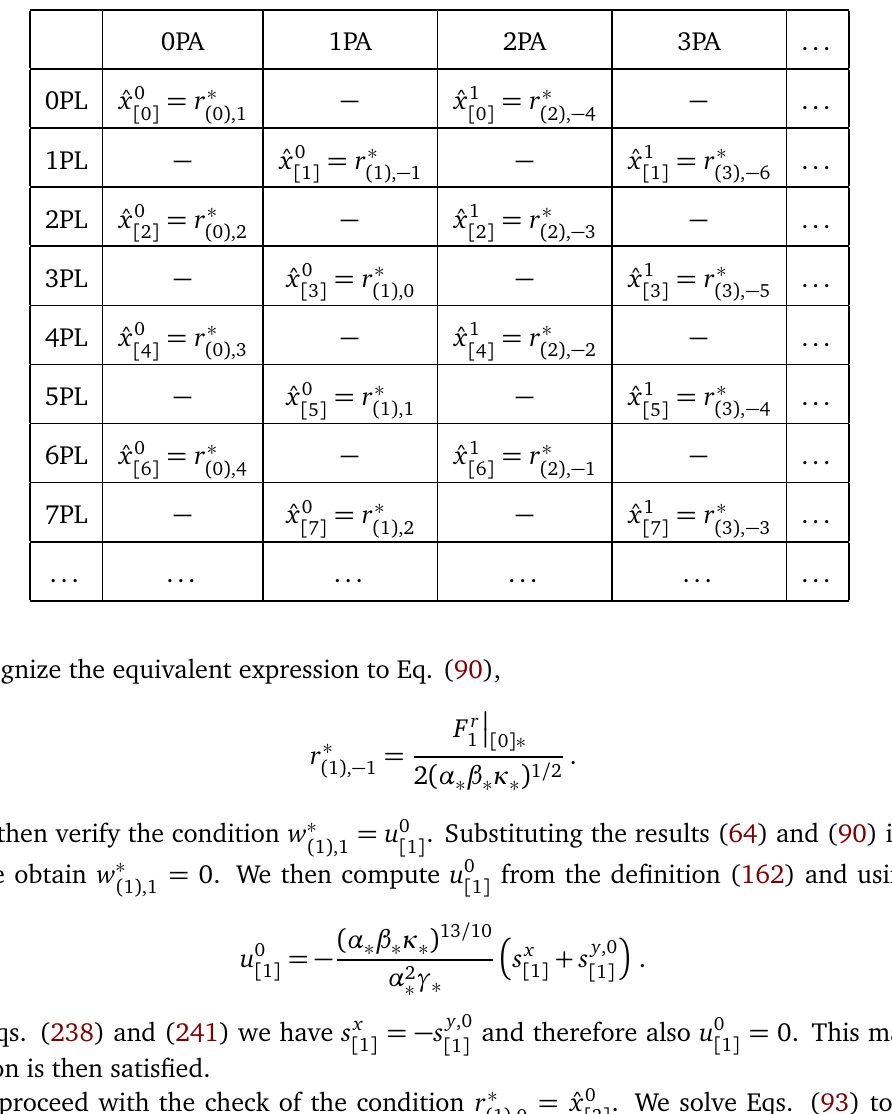
Table 2: Visualization of the structure of the matching conditions derived in Eq.